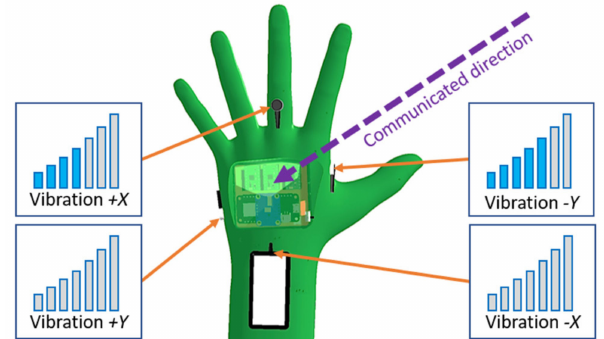
Figure 6. In directional feedback mode, HMI notifies the user about the direction of a possible collision through a difference in activation of tactors located around the hand.